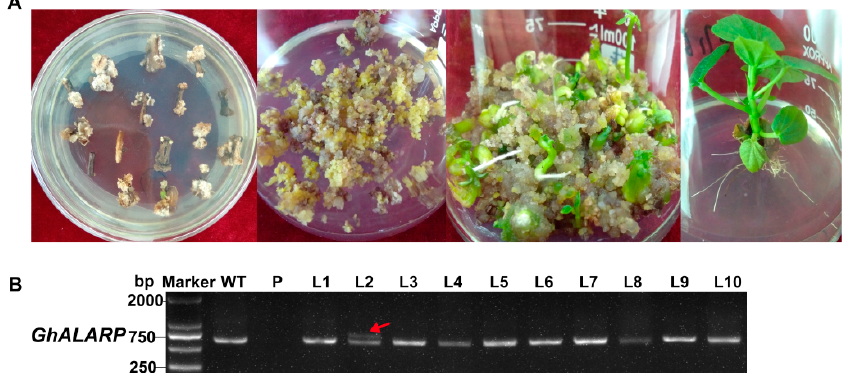
Figure 2. Cotton transformation and analysis of the target site. ( A ) The regeneration process of cotton transgenic plants; ( B ) Gel analysis of the PCR products amplified from the target sites of the 10 independent transgenic cotton plant events (L1 to L10). Lanes wild type (WT) (648 bp) and P are the PCR products from the non-transformed wild-type plant YZ-1 (negative control for the target site) and the 35S:Cas9 construct (positive control for the target site), respectively. The red arrow shows the PCR product with a potentially relatively-large insert in the target site.